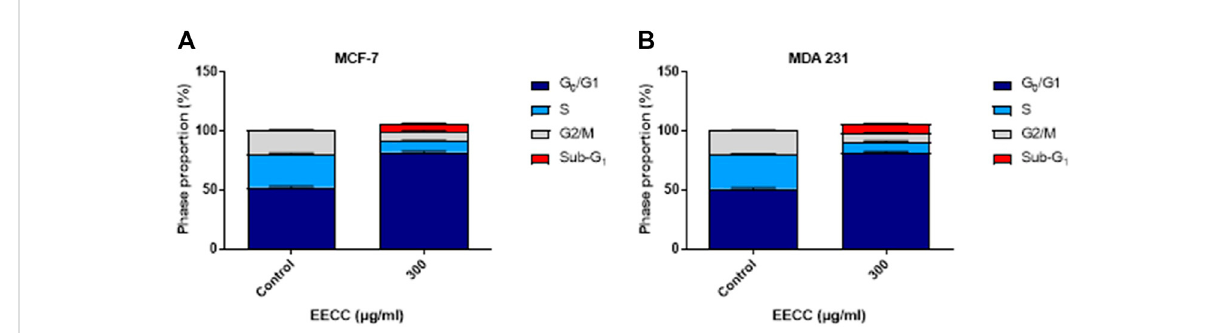
FIGURE 4 Ethanolextractof Colligonumcomosum (EECC)causescellcyclearrestinMCF-7andMDA231cells.Followingtreatmentfor48 hwith300 μ g/ ml of EECC, cells were analyzed for DNA content as detailed in the Methods section.